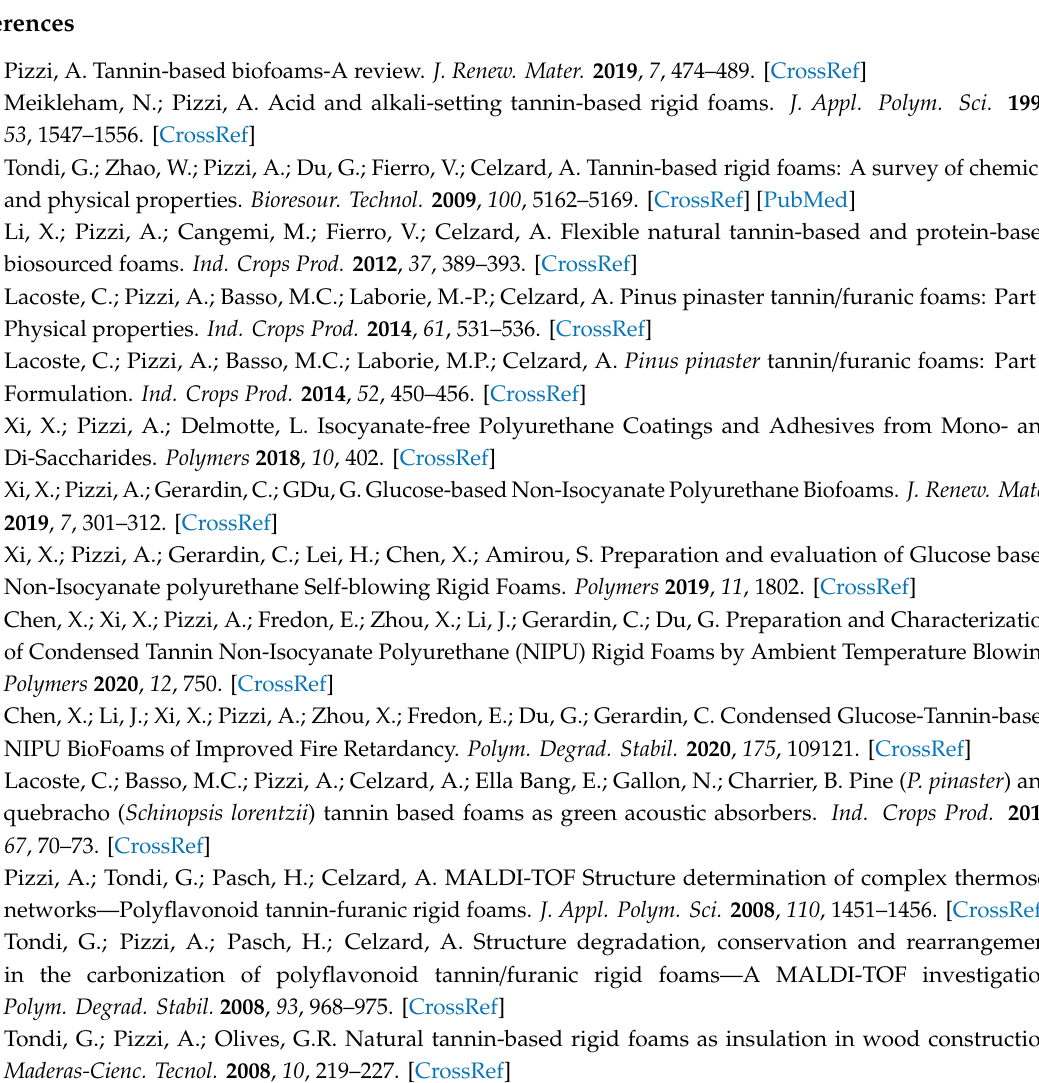
Figure SM1. Title: MALDI ToF spectrum of humins obtained at 180 ◦ C oxidized, from fructose, 1000–1500 Da range. Reported to indicate 1137 Da peak. Figure SM2. Title: MALDI ToF spectrum of humins obtained at 150 ◦ C from fructose, 1000–1500 Da range. Reported to indicate 1250 Da peak. Figure SM3. Title: Photograph of cut section of initial tannin-humin foam formulations (a) cured at 80 ◦ C, (b) cured at ambient